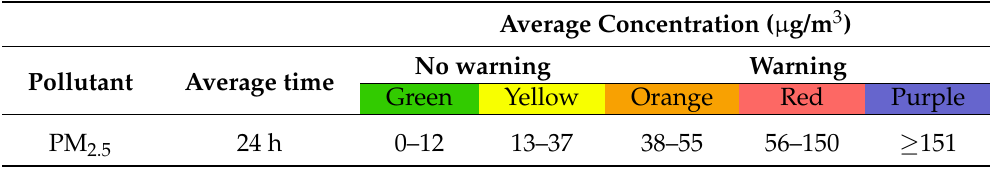
Figure 4. Graphic explanation of the experimental forecast setup. The arrows represent the inher- itance of the last correction factor 24-hourly profile into the forecast. All simulations start at 23 February 19:00 UTC-5. A spin-up period consisting of the 5 days prior to the start date was used for each simulation. Table 3. Air Quality Index (AQI) as defined for the Aburrá Valley with respect to PM 2.5